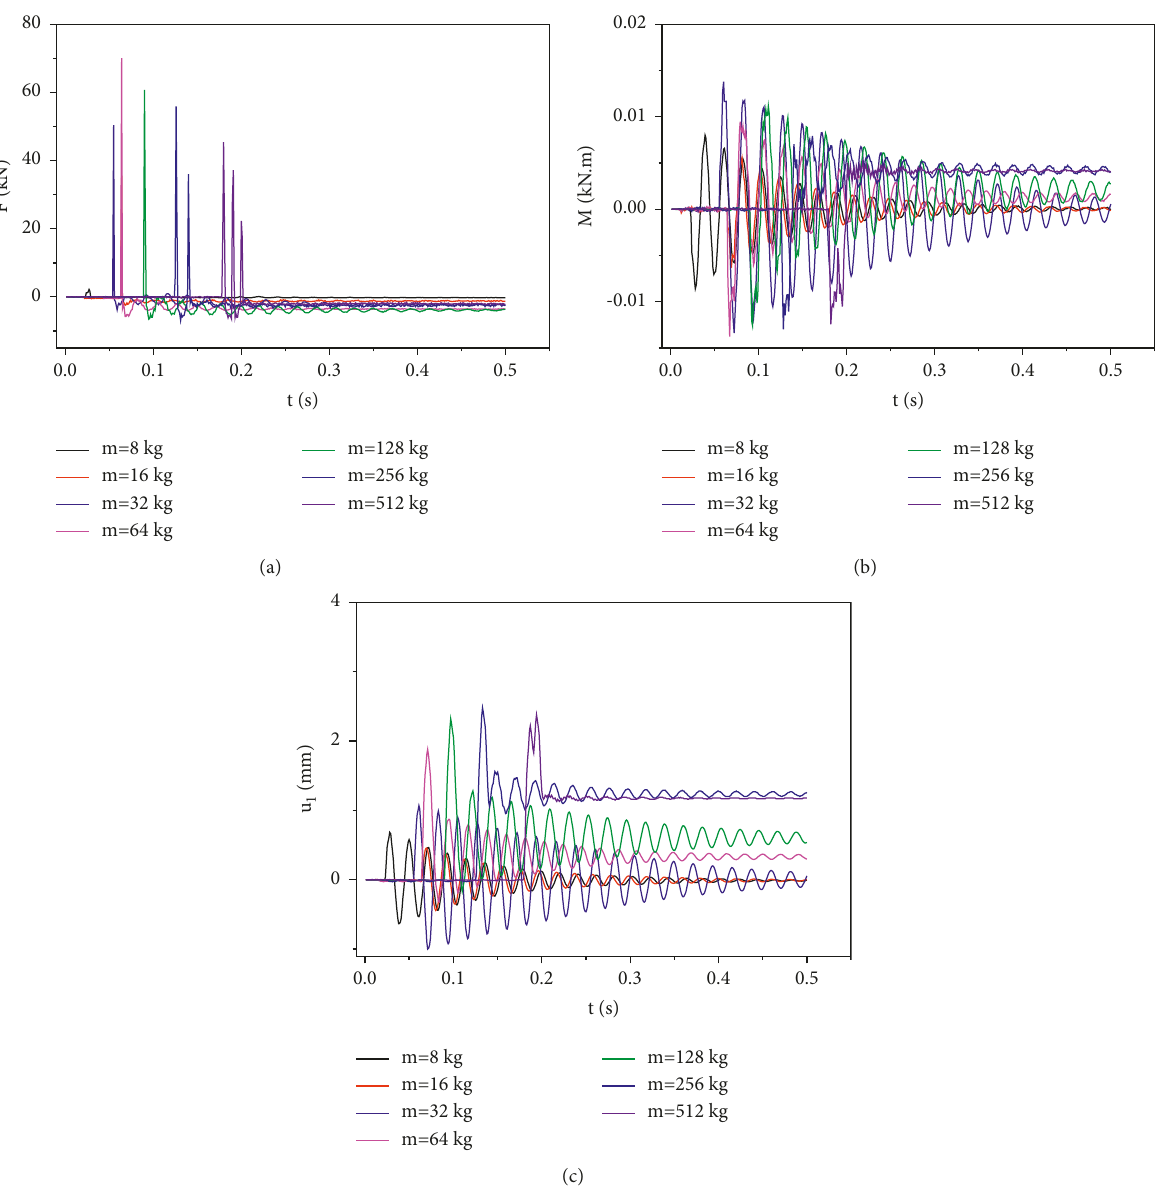
Figure 7: Dynamic response when Ek � 0.02kJ. (a) F- t ; (b) M- t ; (c) u1- t